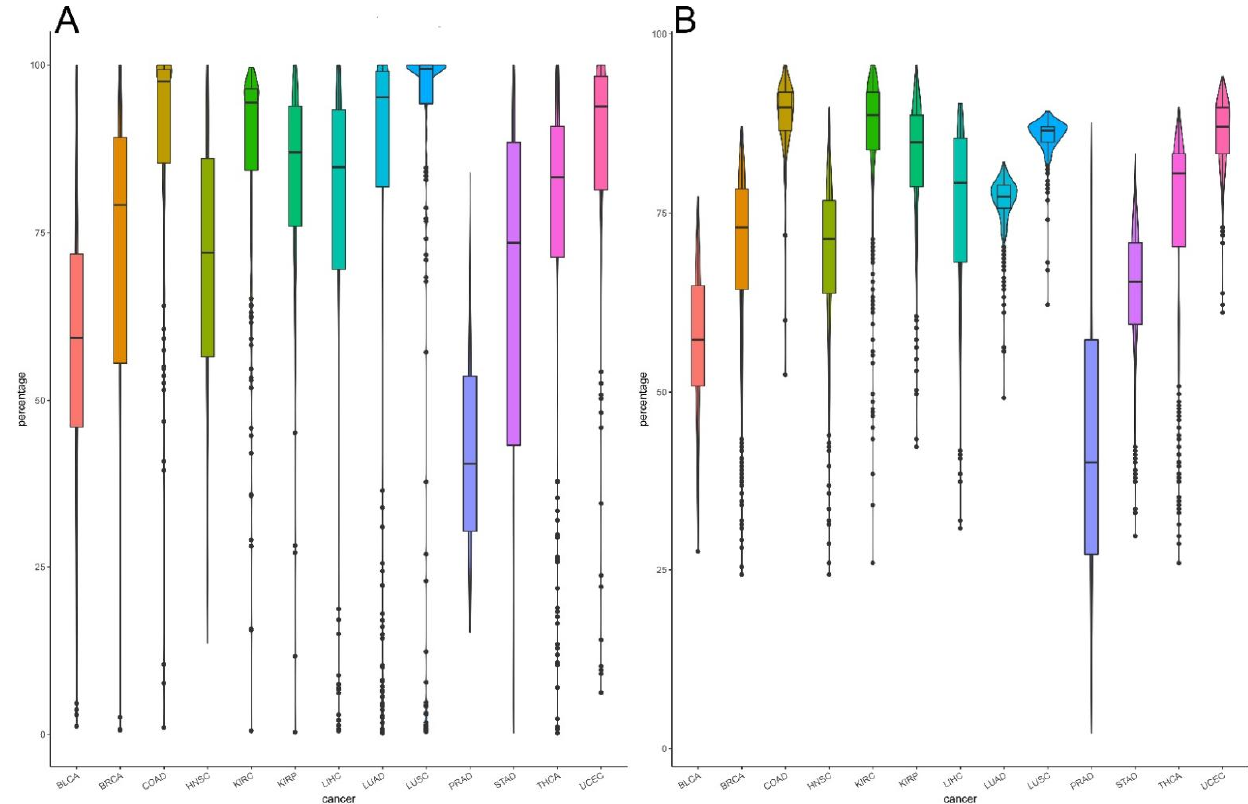
Figure 5. Violin plot showing deregulation in each cancer type: ( A ) the percentage of samples deregulated in each pathway in the 13 cancer types. The different colors represent different patient samples of each cancer type. COAD, LUSC, and KIRC showed deregulation of 89%, 86%, and 86% of pathways, respectively; ( B ) percentage of deregulated pathways in each patient. High percentages were observed in patients with COAD, LUSC, and